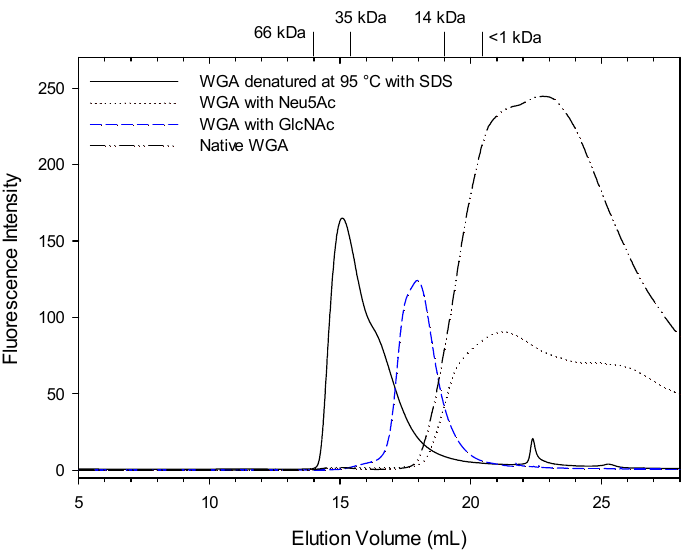
Figure 1. Wheat germ agglutinin ( WGA) under four different conditions: Native WGA, WGA with N-acetyl neuraminic acid, WGA with N-acetyl glucosamine and WGA after heating with SDS buffer at 95 °C for 7 min. Arrows indicate the molecular weight of standards eluting at that volume. The standards used to determine molecular size were: bovine serum albumin (BSA) 66 kDa, β -lactoglobulin 35 kDa, lysozyme 14 kDa, vitamin B12 1.3 kDa and glutathione 0.3 kDa.